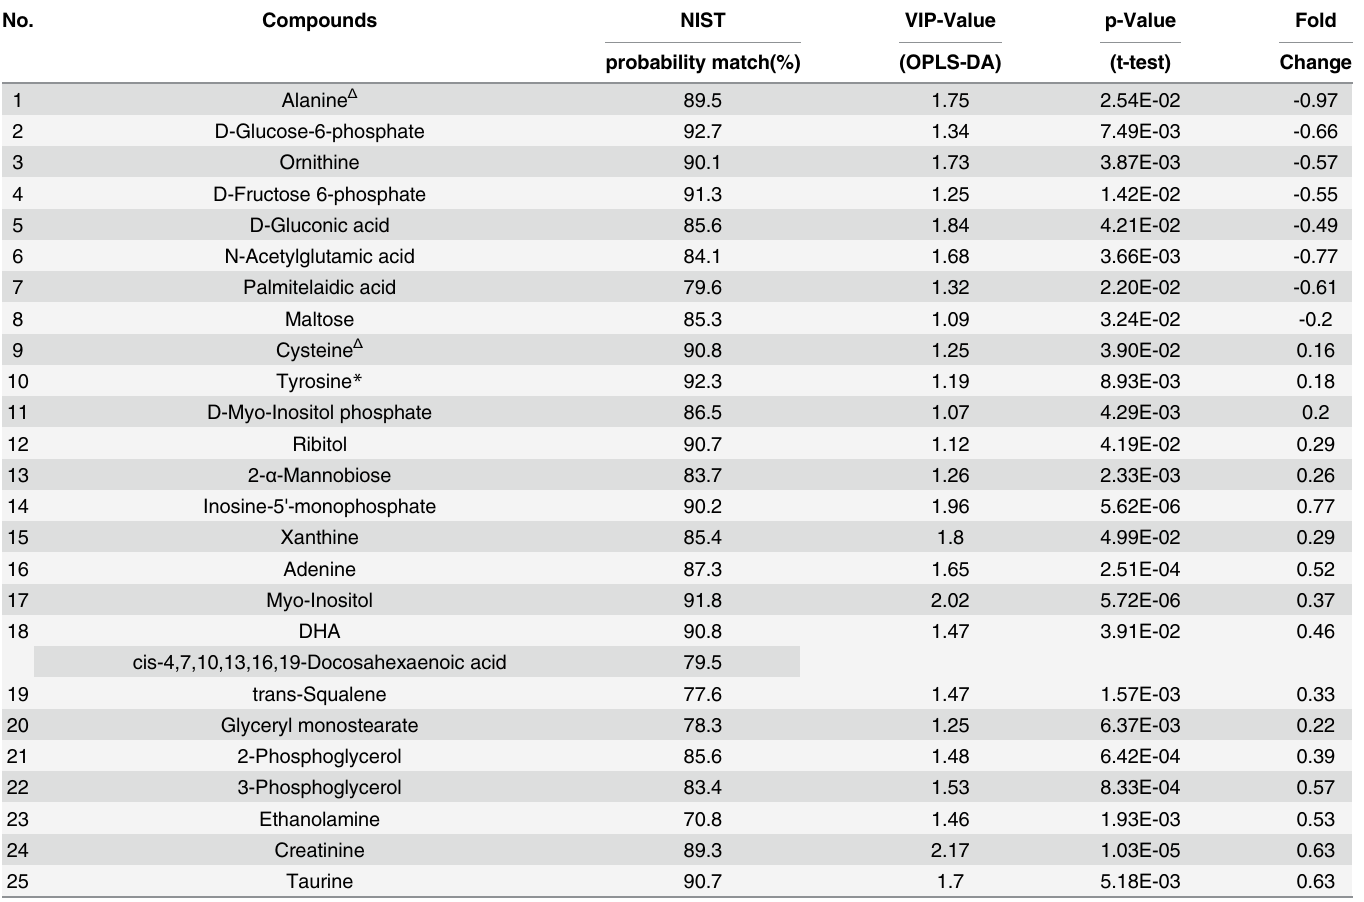
Table 4. The differential metabolites in liver between G6PDx-FB and G6PDx control mice.